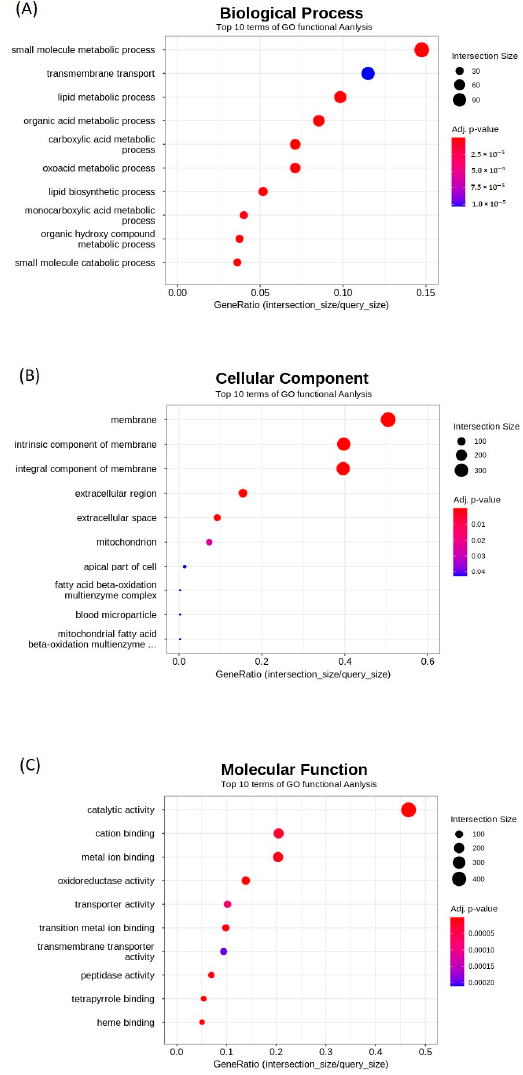
Figure 6. Top 10 terms of GO functional enrichment analysis. Biological process (BP) ( A ), cellular component (CC) ( B ), and molecular function (MF) ( C ) terms associated with differentially expressed genes.